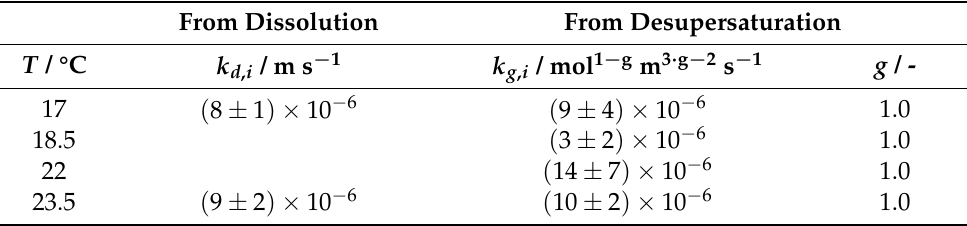
Table 1. List of estimated binary kinetic coefficients k g , i and crystallization orders g of sodium sulfate decahydrate at different equilibrium temperatures. From Dissolution From Desupersaturation